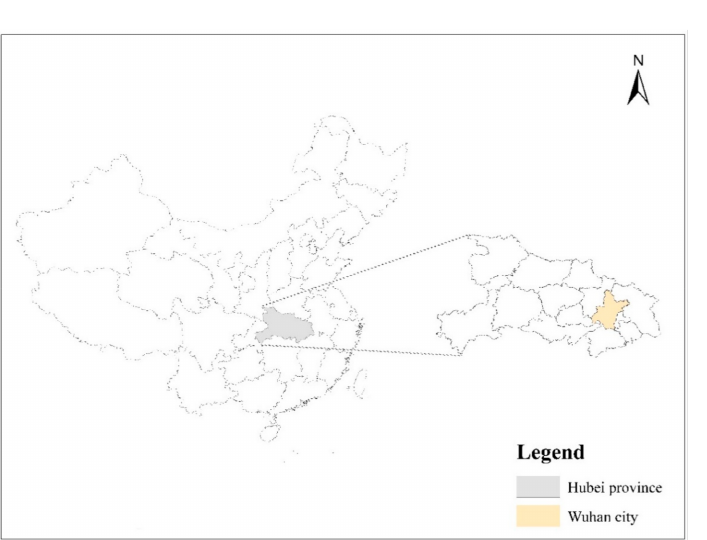
Figure 1. The geographical location of Wuhan city in